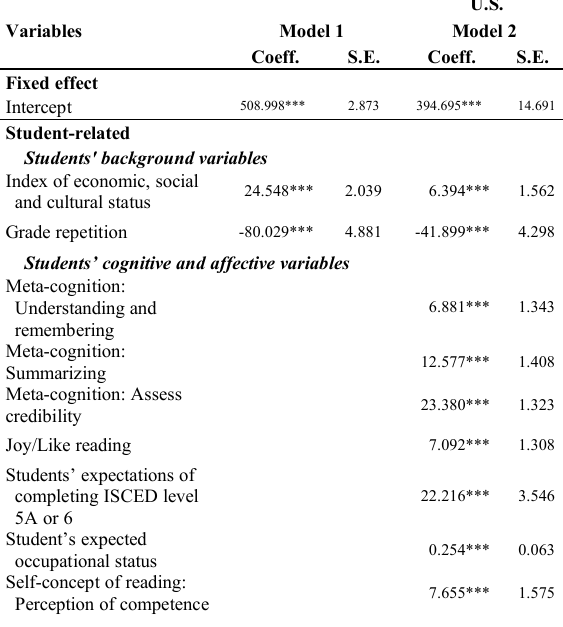
Effect of variables on students’ reading literacy in the U.S. and South Korea